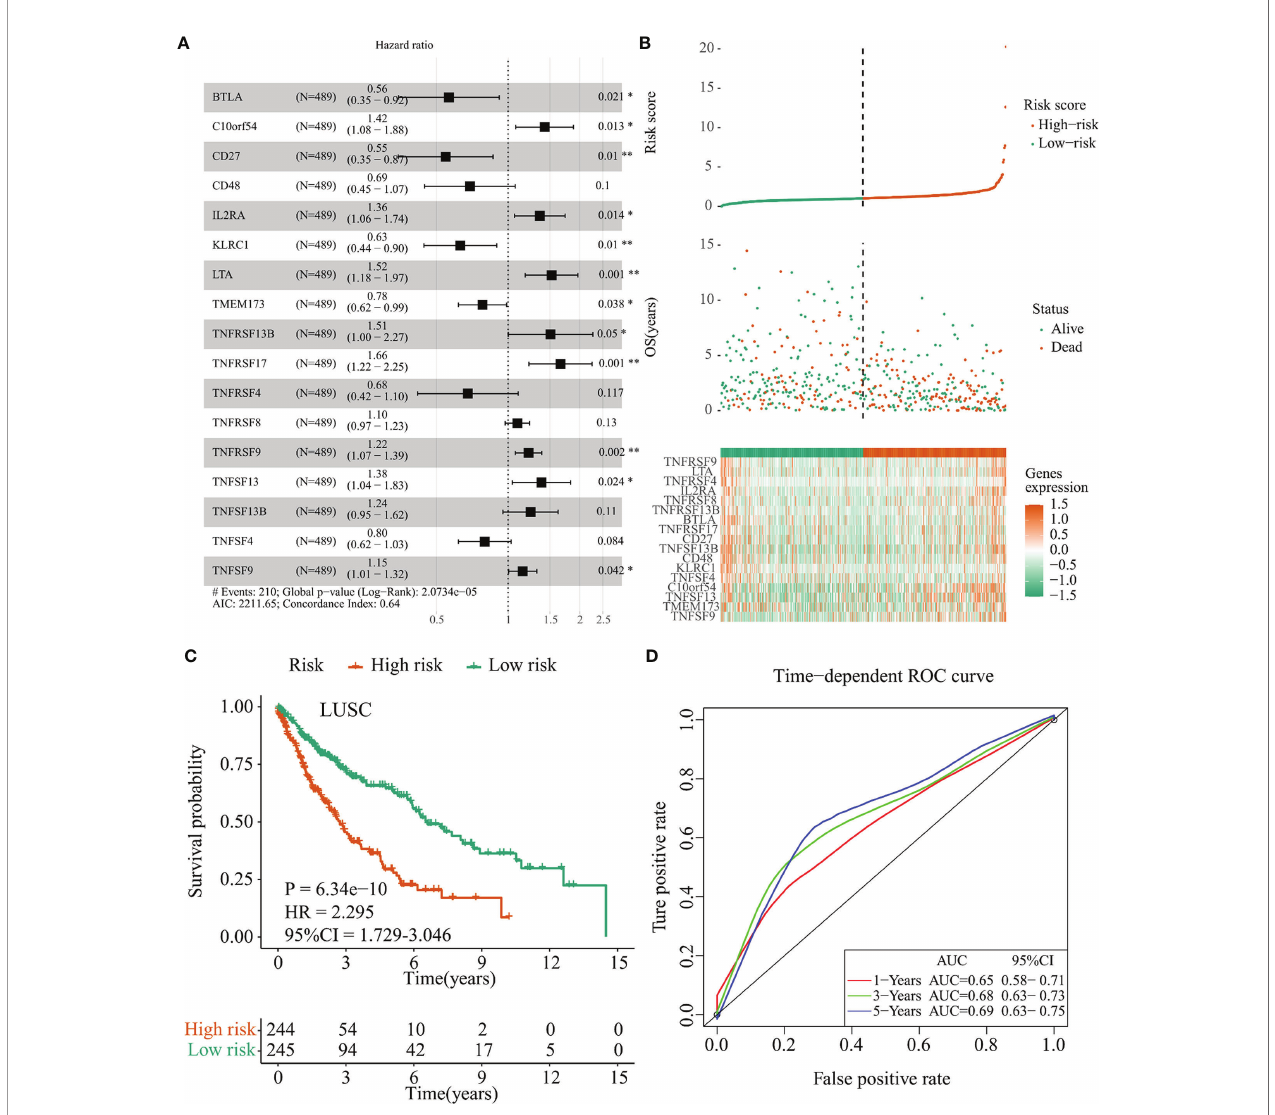
FIGURE 5 | Establishment of the IFI44L -related immunomodulator signature in the TCGA-LUSC cohort. (A) Development of the prognostic signature based on 57 IFI44L -associated immunomodulators through multivariate stepwise Cox analysis, and the results are shown in a forest plot. (B) Distribution of the risk score, survival status, and expression pro fi ling of immunomodulators integrated in this signature. (C) The cohort was separated by median cutoff value of risk score, and the difference in survival was performed using a Kaplan – Meier plot. (D) Time-dependent ROC curves at 1 year, 3 years, and 5 years for evaluating the speci fi city and sensitivity of this risk signature. TCGA, The Cancer Genome Atlas; LUSC, lung squamous cell carcinoma; ROC, receiver operating characteristic. * p < 0.05, ** p <